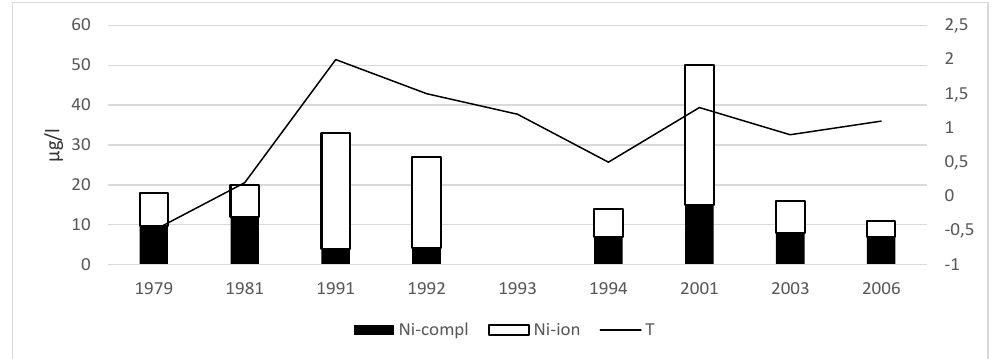
Figure 5. Temperature trend and change in labile and non-labile forms of Ni.